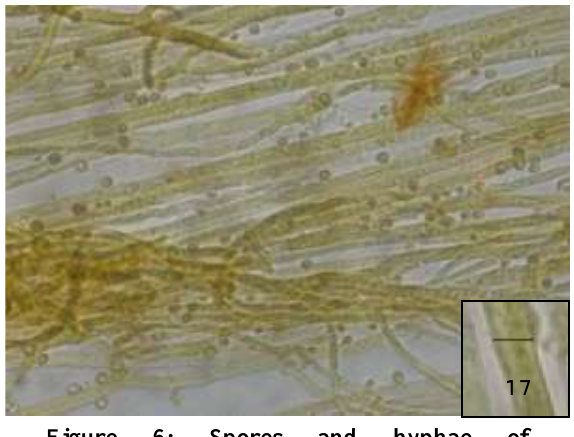
Figure 7: Spores and hyphae of Branchiomyces spp. stained with Lactophenol cotton blue stain from